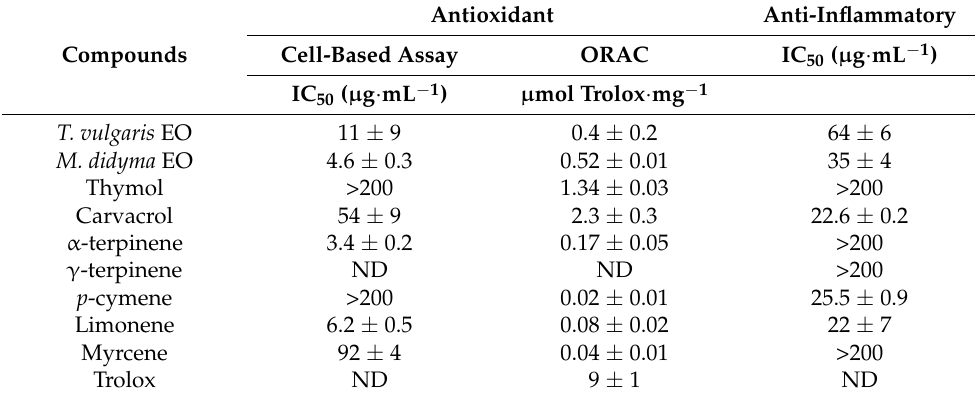
Table 3. Antioxidant and anti-inflammatory activity of M. didyma and T. vulgaris (as positive control) essential oils and the main